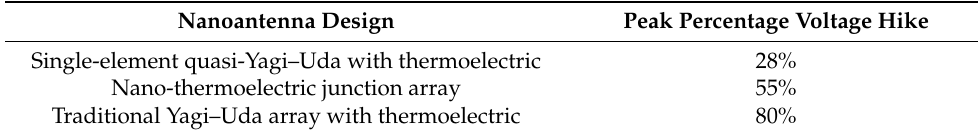
Table 2. Comparison of the peak percentage voltage hikes shown in Figure 12 when excited with a 1550-nm laser source.